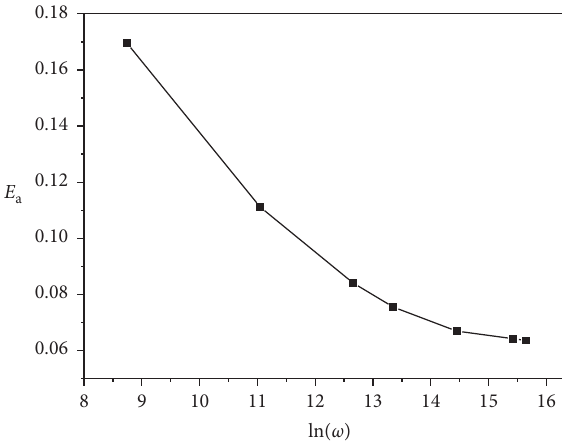
Figure 6: Activation energy vs. frequency of PEcbz-Ter.